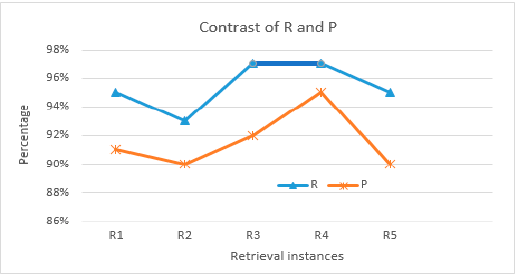
Figure 11. Comparison of R and P.